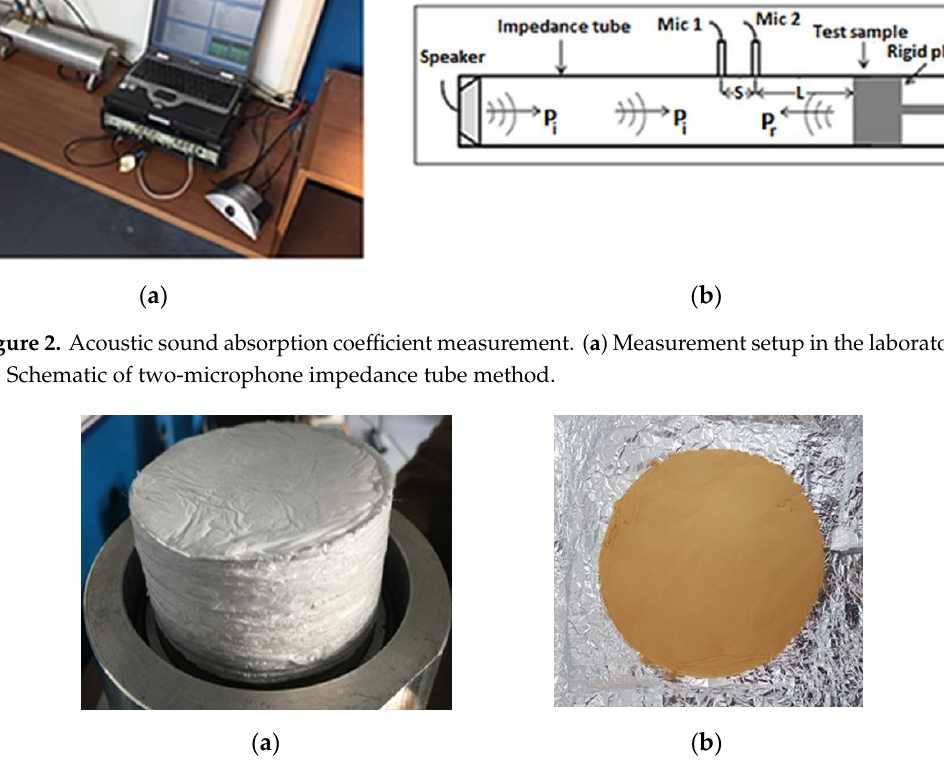
Figure 3. Photographs of electrospun PVP_SiO 2 NT piled mats ( a ) and PVP_SiO 2 HT mat ( b ).